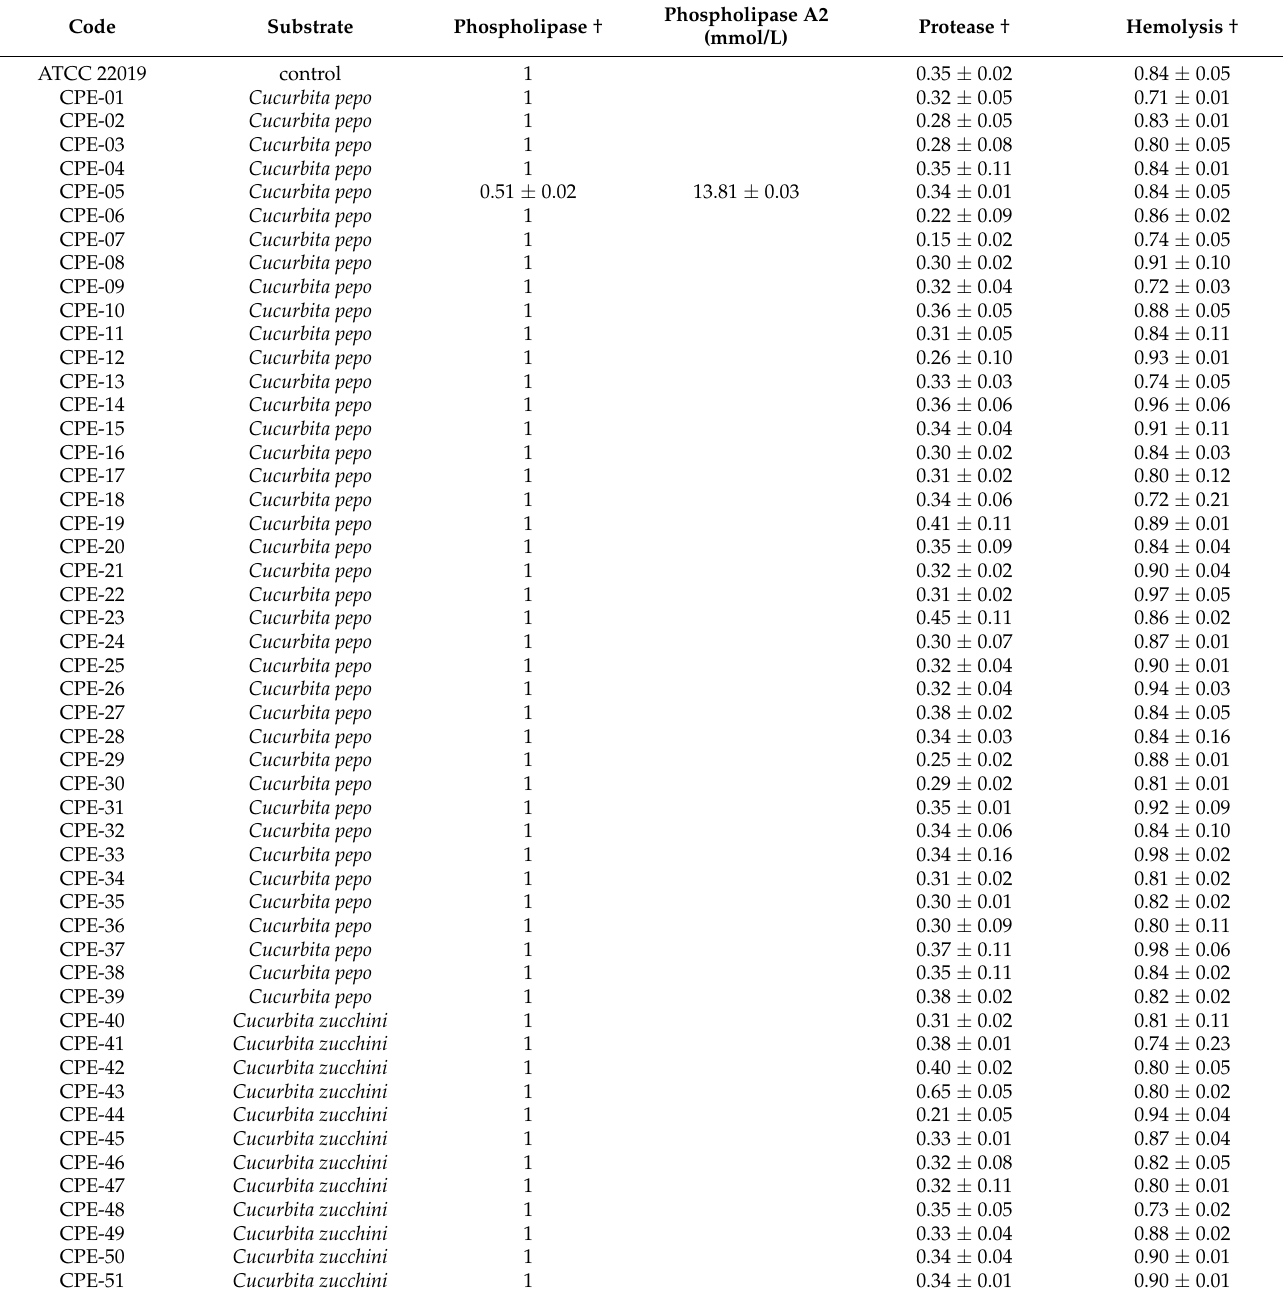
Table 3. Hydrolytic enzyme production by endophytic strains belonging to Candida parapsilosis and isolated from ripe vegetables and fruits (mean values with standard